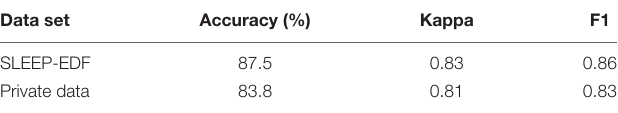
TABLE 4 | The performance of MSDFN using multi-channel data.